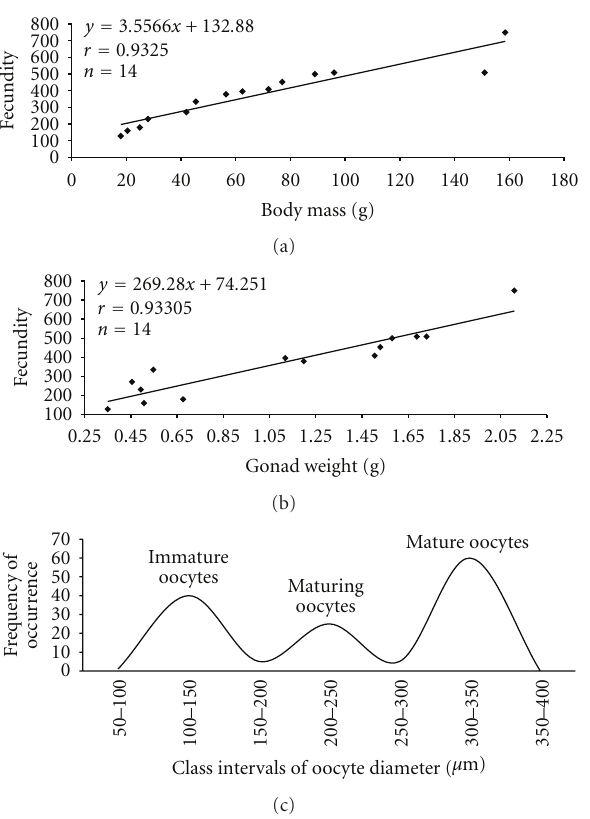
Figure 6: (a) Relationship between fecundity and body mass; (b) relationship between fecundity and weight of gonads; (c) frequency of occurrence of oocytes of di ff erent class intervals of mature C. menezesi .